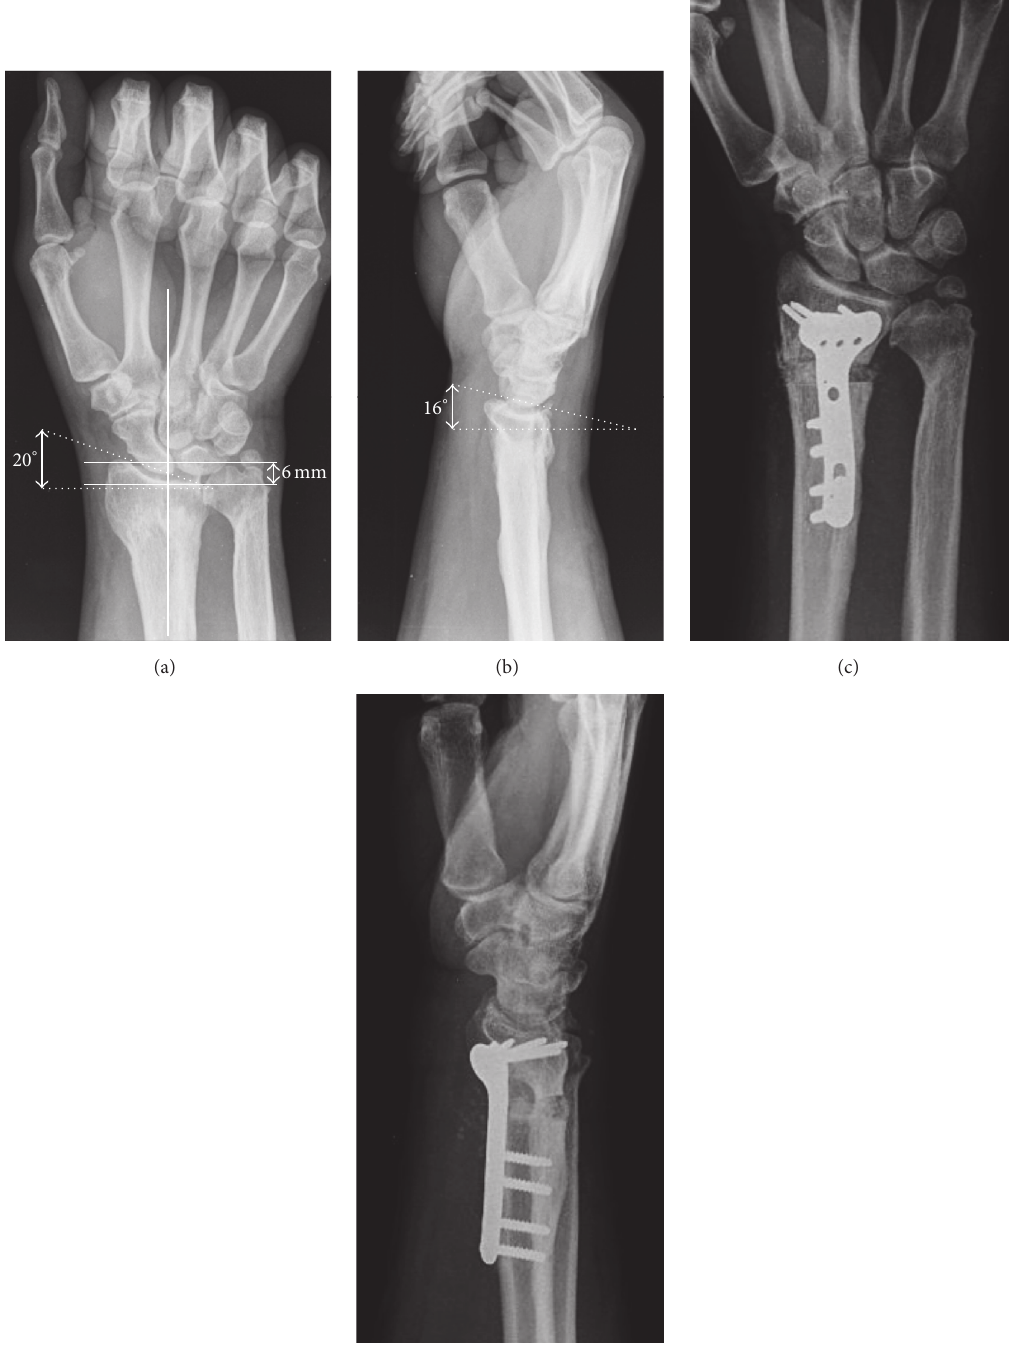
Figure1:(a-b)PlainradiographspreoperativeimagesshowedDRmalunionwithalossofvolartilt( − 15 ∘ ),radialinclination(20 ∘ ),andpositive ulnar variance (6mm). (c-d) Postoperative radiographs showed DR osteotomy with a correction of volar tilt (2 ∘ ), radial inclination (22 ∘ ), and ulnar variance